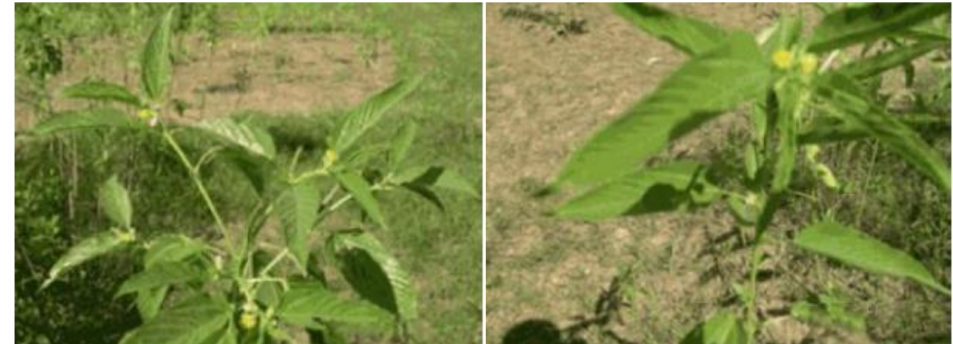
Figure 8. Jute plant. Reproduced with permission from Ramesh et al. [195].